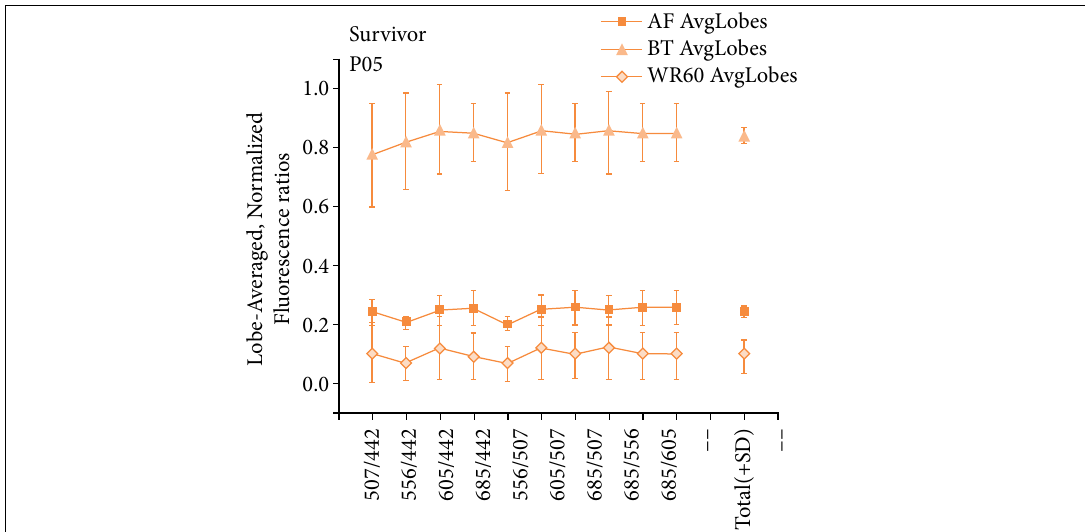
Figure 2 - Ratio between emission maxima (RBEM) of fluorescence: typical surviving patient. The RBEM for wavelengths 442, 507, 556, 605 and 685 nm (patient P05; the graph represents typical results for surviving patients; others can be seen in the Supporting Information).